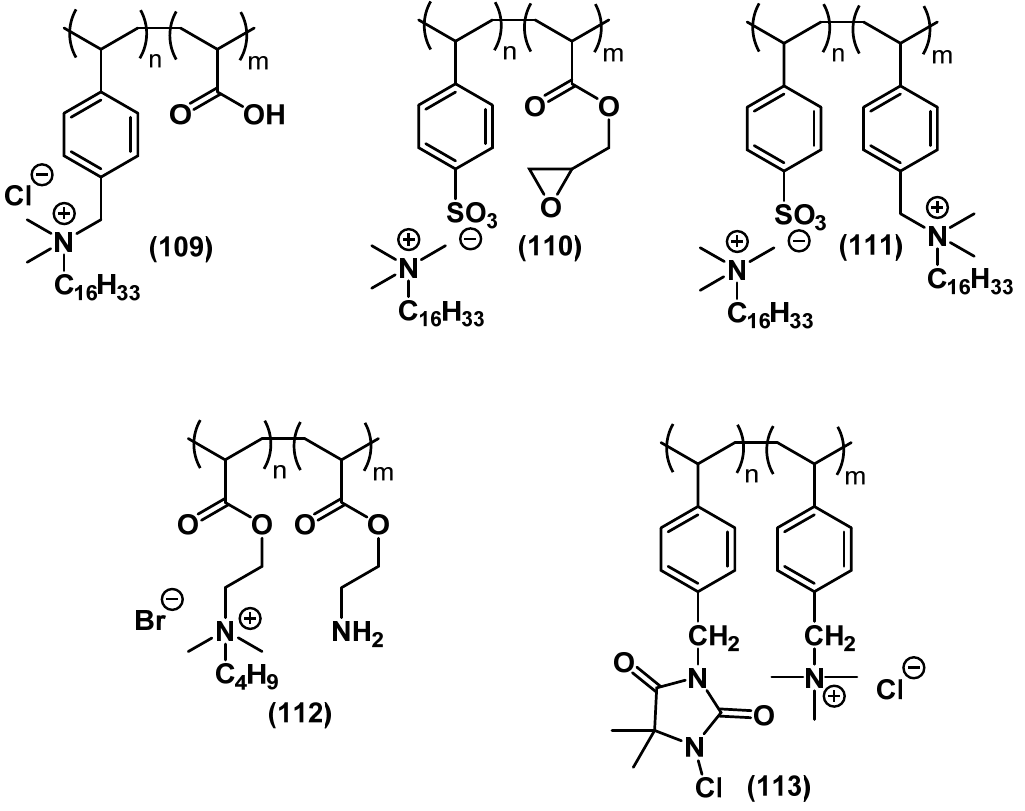
Figure 34. Copolymer poly-QACs.